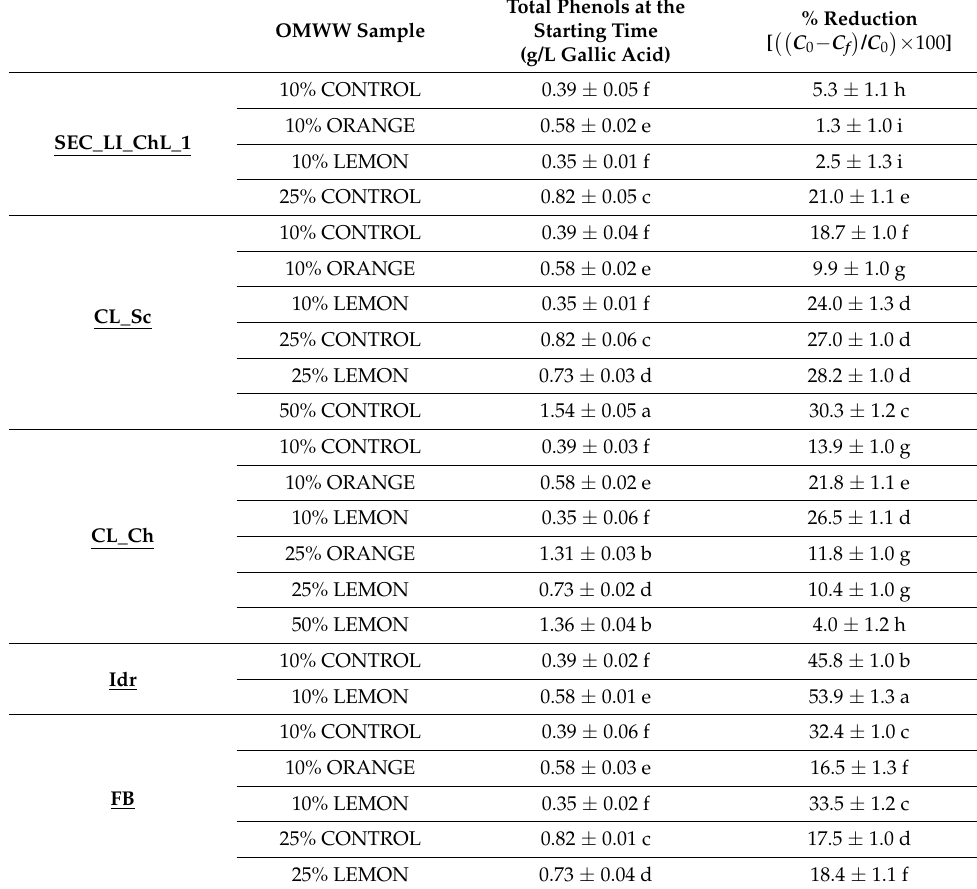
Table 2. Total phenols at the starting time and their percentage reduction after one-week treatments in the preliminary screening performed on all five microalgal strains (only the best data are reported).